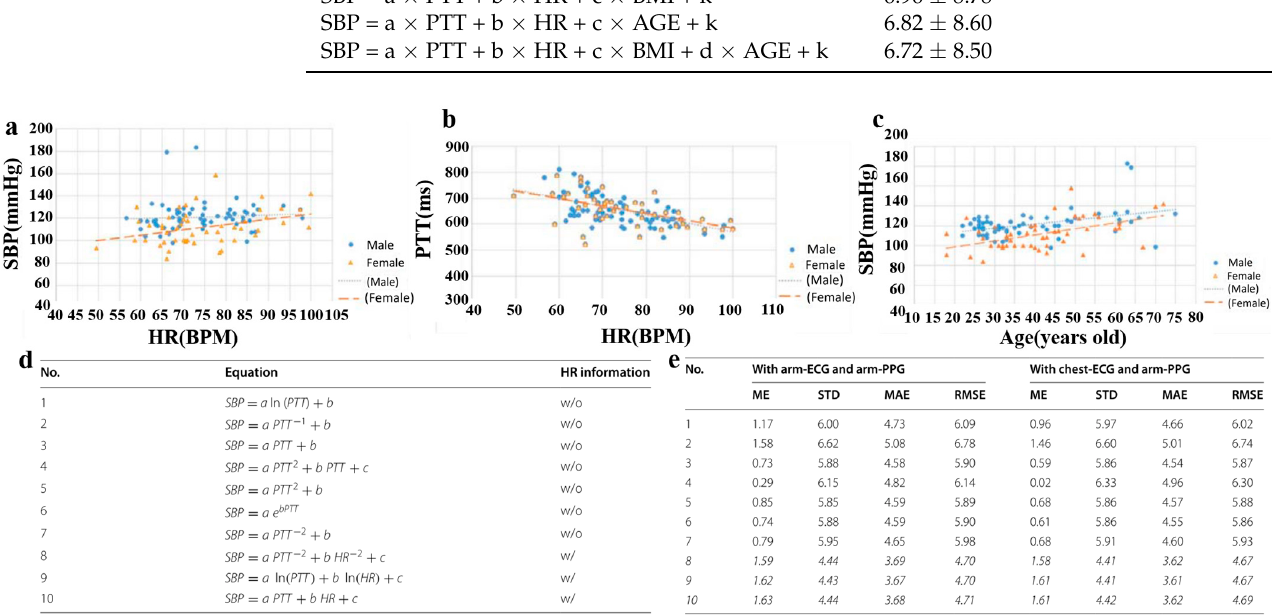
Figure 14. ( a ) Relationship between HR and BP; ( b ) Relationship between HR and PTT; ( c ) Relationship between gender, age, and SBP; Reproduced with the permission of [78]. Copyright 2016, IEEE. ( d ) Ten BP models for comparative analysis; ( e ) The testing performance of ten SBP models. Reproduced with the permission of [70].